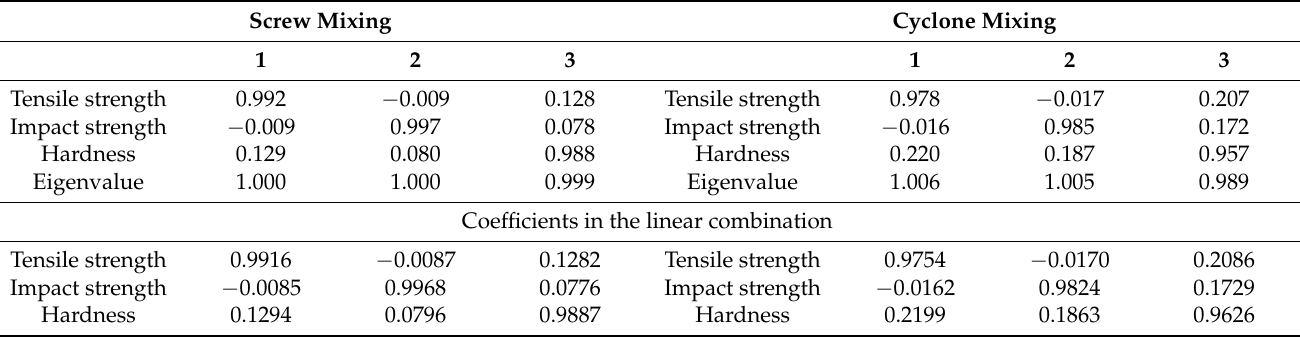
Table 9. Linear combination coefficients of principal components.